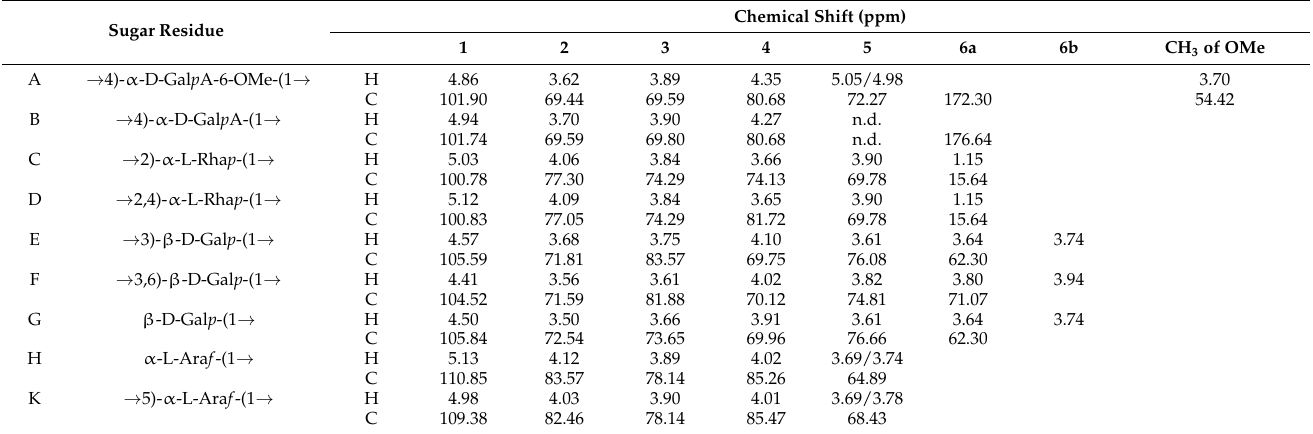
Table 3. 1 H NMR and 13 C NMR chemical shifts of GP2a recorded in D 2